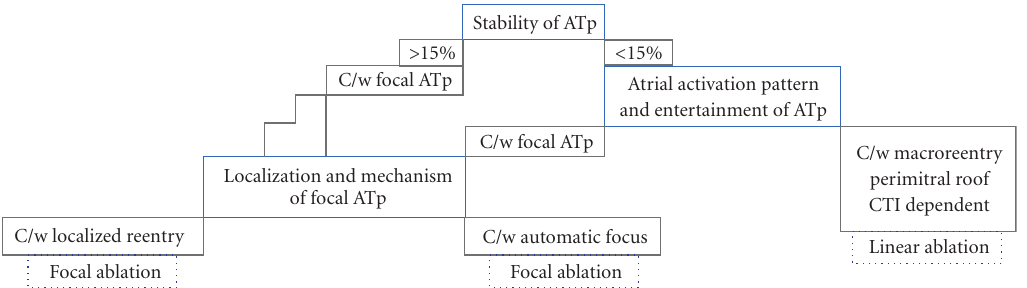
Figure 2: Stepwise Diagnostic Algorithm: A three-stepped approach to the diagnosis of atrial tachycardia during/post AF ablation (ATp). C/w—consistent with, CTI—cavotricuspid isthmus. (Modified from Jais et al. [22])